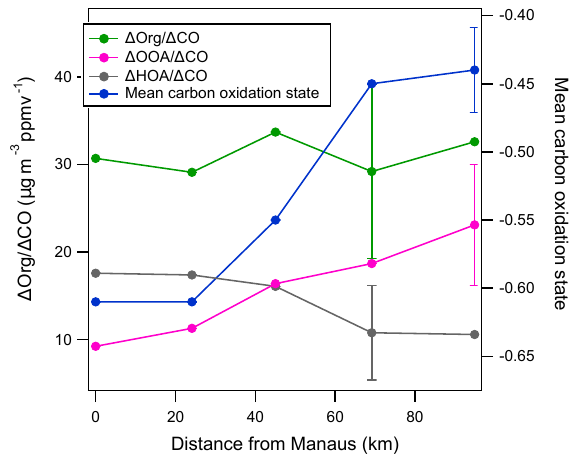
Figure 7. Key metrics describing the evolution of the Manaus urban plume on 13 March. Each data point represents the average values for one pass through the plume. A representative error bar is shown for each set of measurements. Mean wind speeds were 7.3ms − 1 on this flight, thus data capture approximately the first 4–5h of the plume aging. Calculations of (cid:49) Org /(cid:49) CO values use method one with details on the calculations and methods provided in the text and the Supplement. Spatial locations of each leg are labelled in Fig.